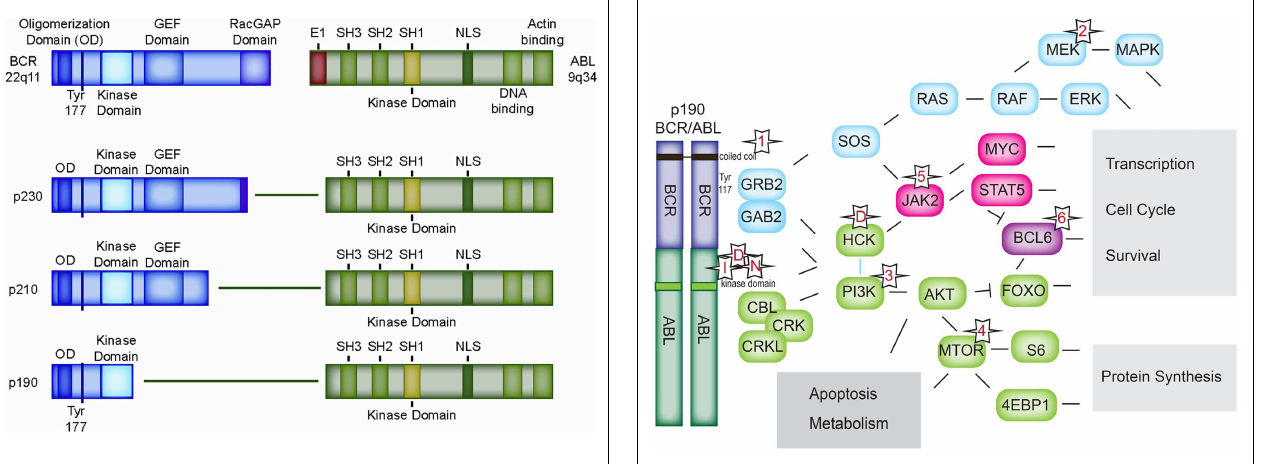
FIGURE 2 | Structure of the most common BCR–ABL1 fusion genes . Domain structure of wild type BCR and wild type ABL1 protein, as well as retained domains in the three most common BCR–ABL1 variants, p230, p210, and p190. OD: oligomerization domain (coiled-coil domain) mediating oligomerization,Tyr177: tyrosine 177, which, when phosphorylated, serves as a docking site for the adaptor protein GRB-2; SH2-domain: SRC homology 2 (binding to phosphorylated tyrosine residues, including BCR exon 1), SH3-domain: SRC homology 2 (binding to proline rich peptides). SH1-domain: SRC homology 1 (ABL1 catalytic domain); GEF-domain: guanine nucleotide exchange factors (G-protein signaling); E1: exon 1 of